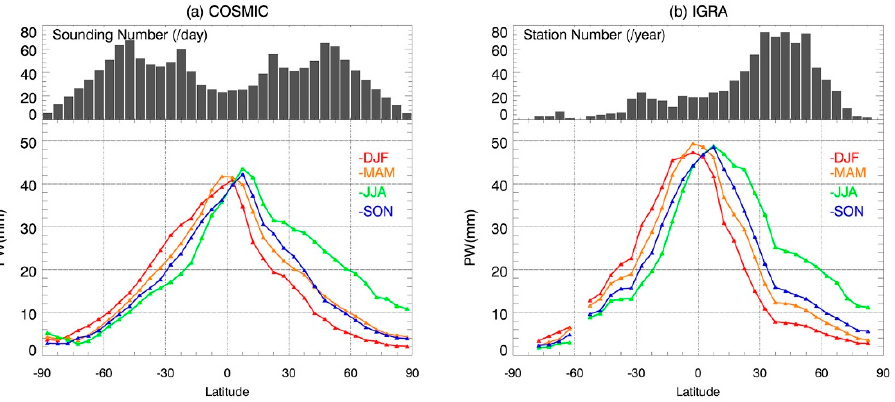
Figure 5. Latitudinal variation of seasonal mean PW derived from two observations ( a : COSMIC; b : IGRA).